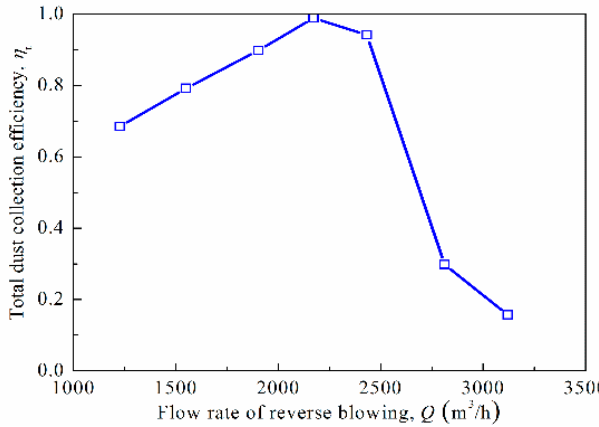
Figure 5. Influence of reverse-blowing flow rate on the total dust-collection efficiency.